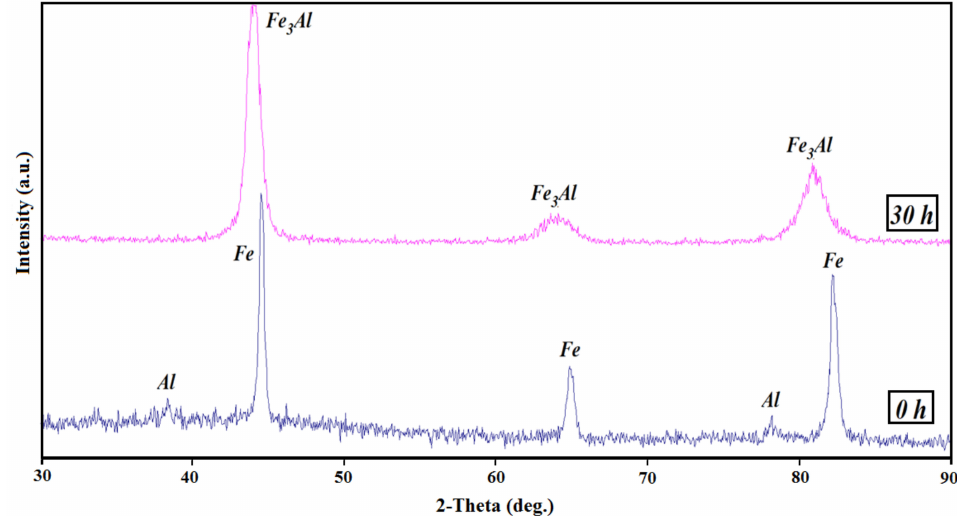
Figure 2. Results of XRD analysis of Fe 75 Al 25 powder mixture before and after 30 h of milling time.